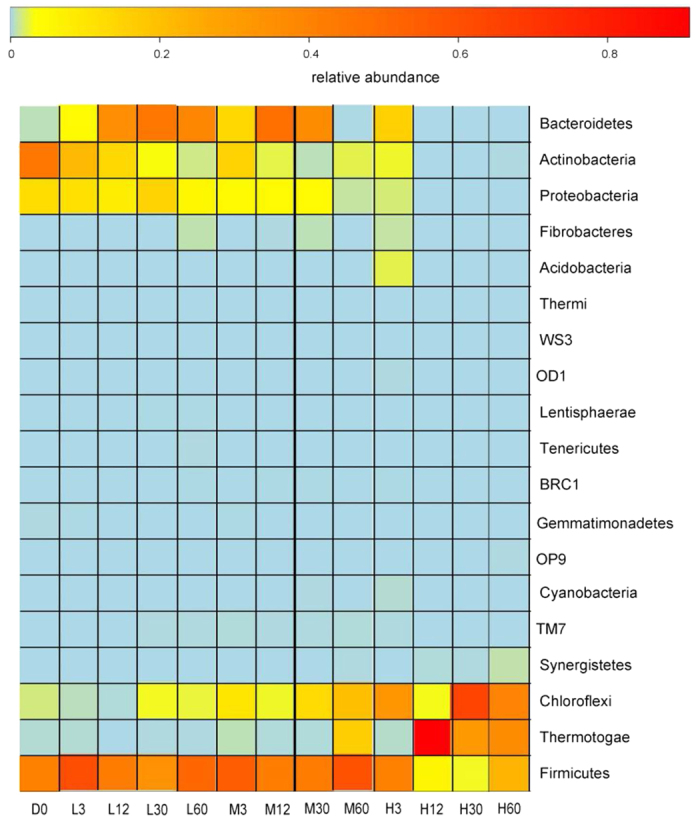
Heatmap showing the relative abundance of phyla during anaerobic digestion at 20 °C (L), 35 °C (M), and 55 °C (H).D0 represent the initial material.